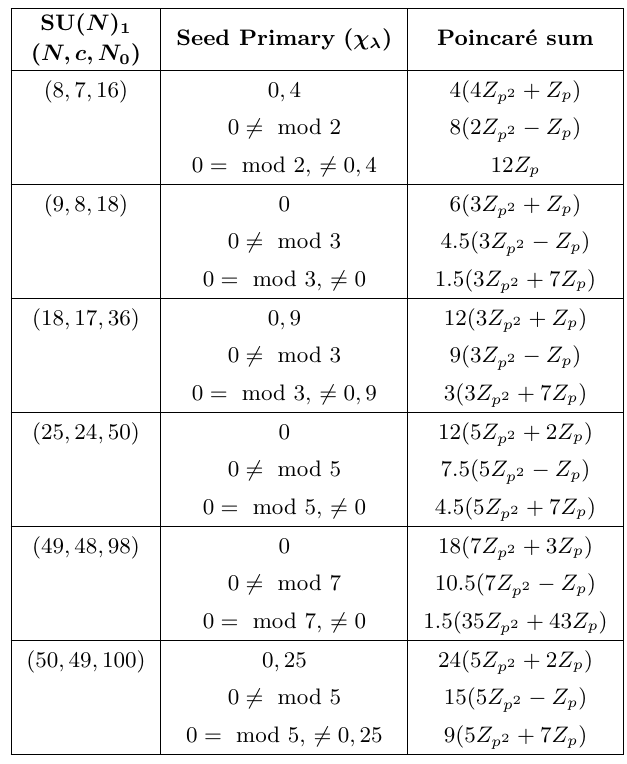
Table 5. Poincaré sums for SU( N ) 1 with two invariants, for N = p 2 , 2 p 2